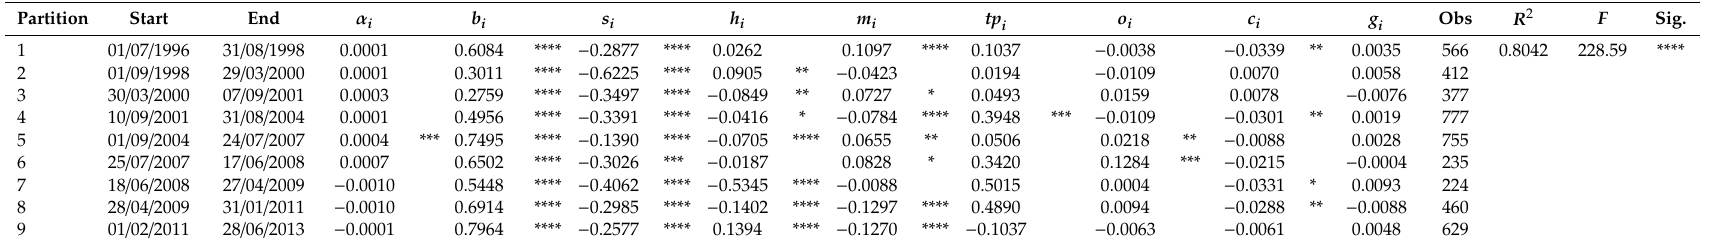
Table 5. Results of the local AFFM breakpoint